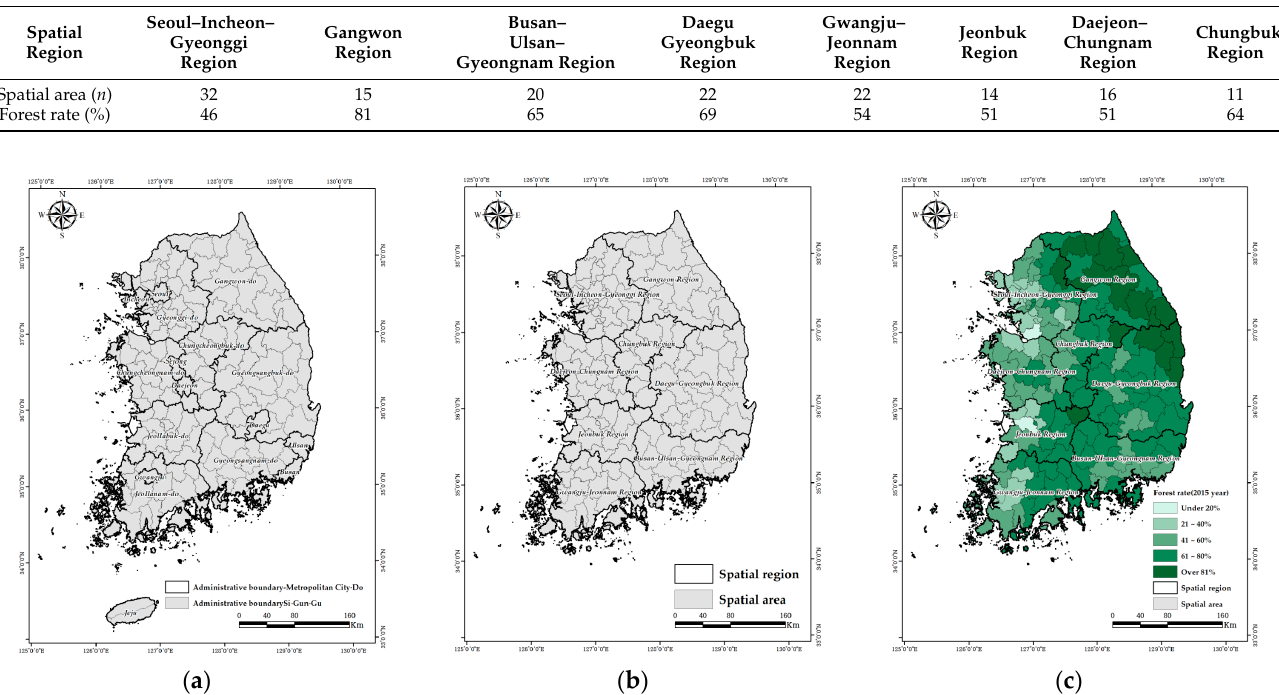
Table 1. Number of spatial areas and forest rate in each spatial region. For the study, “spatial regions” were defined and split into “spatial areas” (see Figure 1).